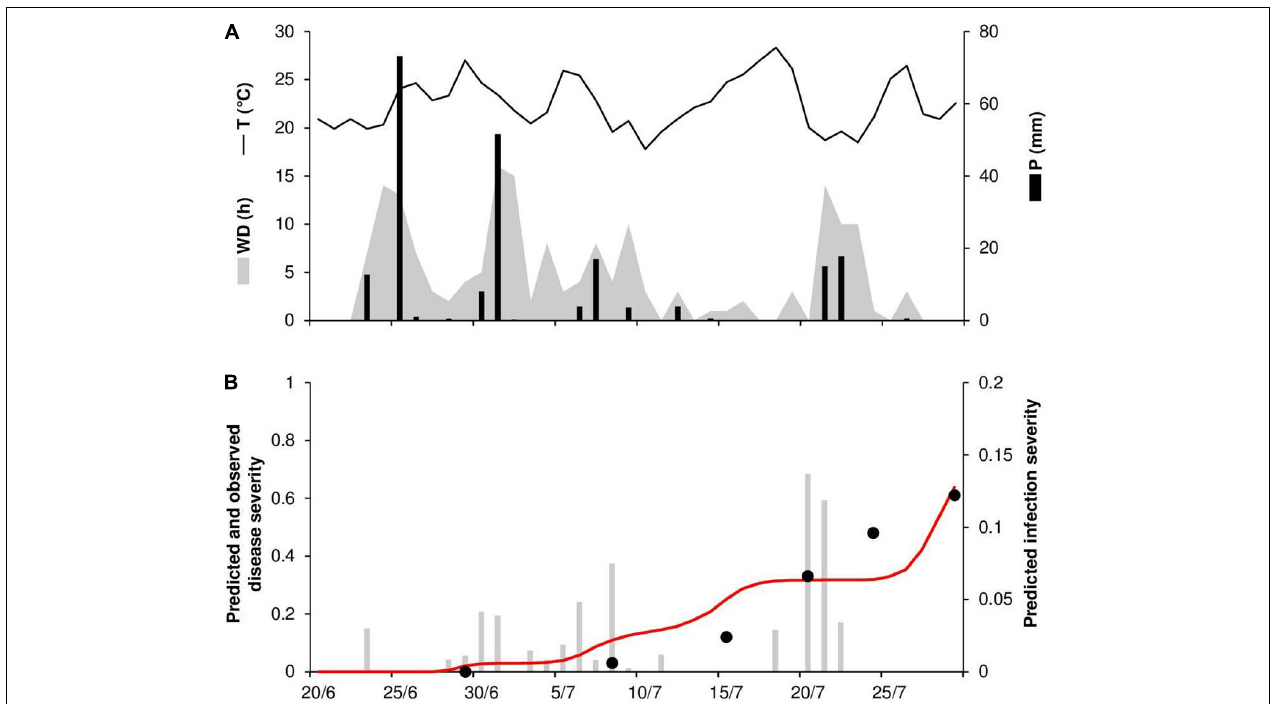
FIGURE 6 | Predicted and observed stem rust progress in the experimental wheat field (susceptible cv. Prelude) in Rosemount, MN, United States, in 1978 (ROS78). (A) Weather variables: air temperature (T, ◦ C, solid line), rainfall (R, mm, black bars), and wetness duration (WD, in h, gray area). (B) Infection severity predicted by the model (gray bars), disease severity predicted by the model (red line), and observed disease severity (full